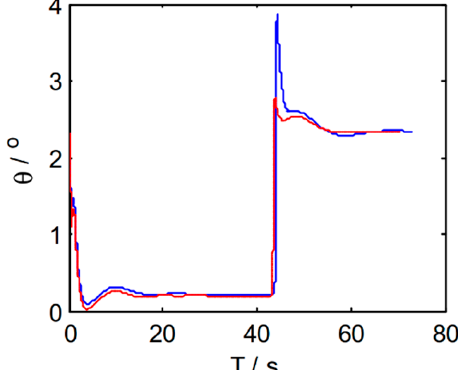
Figure 12. Landing speed in windward conditions.